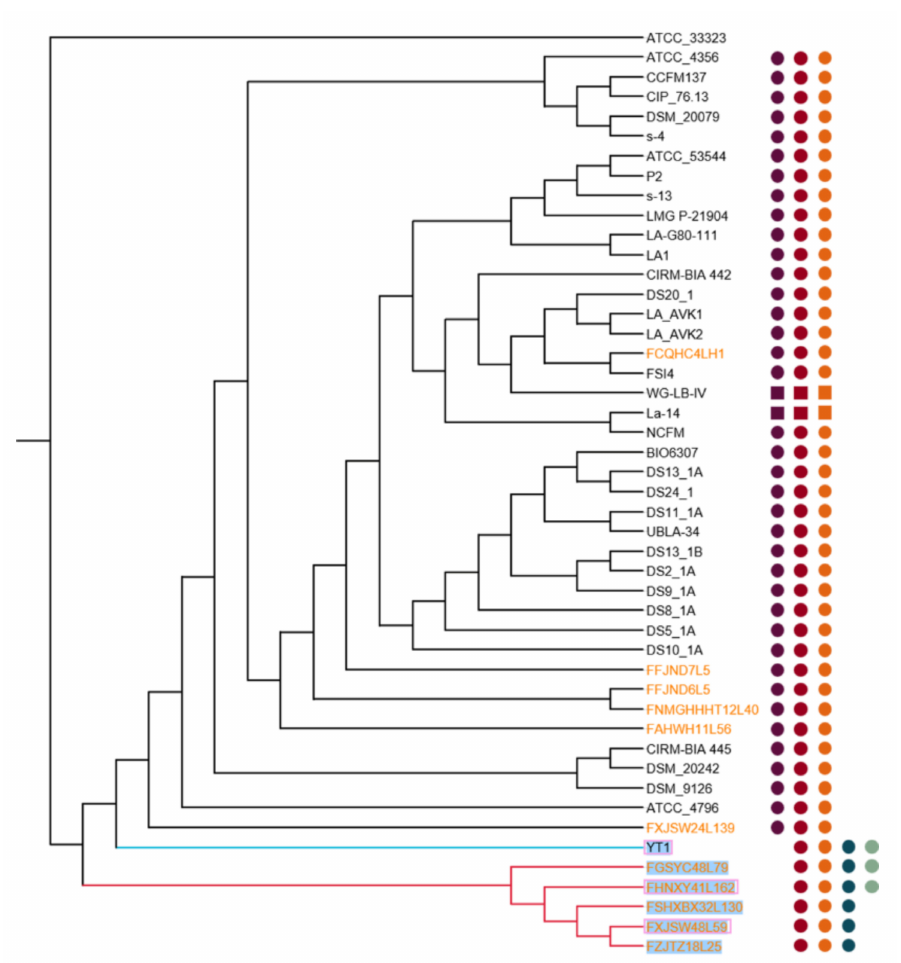
Figure 4. Phylogenetic analysis of L. acidophilus . Phylogenetic tree showing the relationship among 46 L. acidophilus strains with L. gasseri ATCC33323 as outgroup. The tree was grouped into three clades signed by different colors of lines (red represented clade A, blue represented clade B and black represented clade C). The dots represented strains that contained the operon of bacteriocins. In specific, dark purple dots represented Acidocin_J1132_beta_peptide_N-terminal, claret dots represented Bacteriocin_helveticin_J, orange dots Enterolysin_A, mazarine dots Helveticin-J, green dots Lanthipeptide. Additionally, circular dots represented one bacteriocin gene operon while square dots represented two. Orange font represented strains isolated in this study, black represented obtained from NCBI. Pink frames represented strains that contained a complete CRISPR/Cas system. Wathet highlight represented strains contained intact